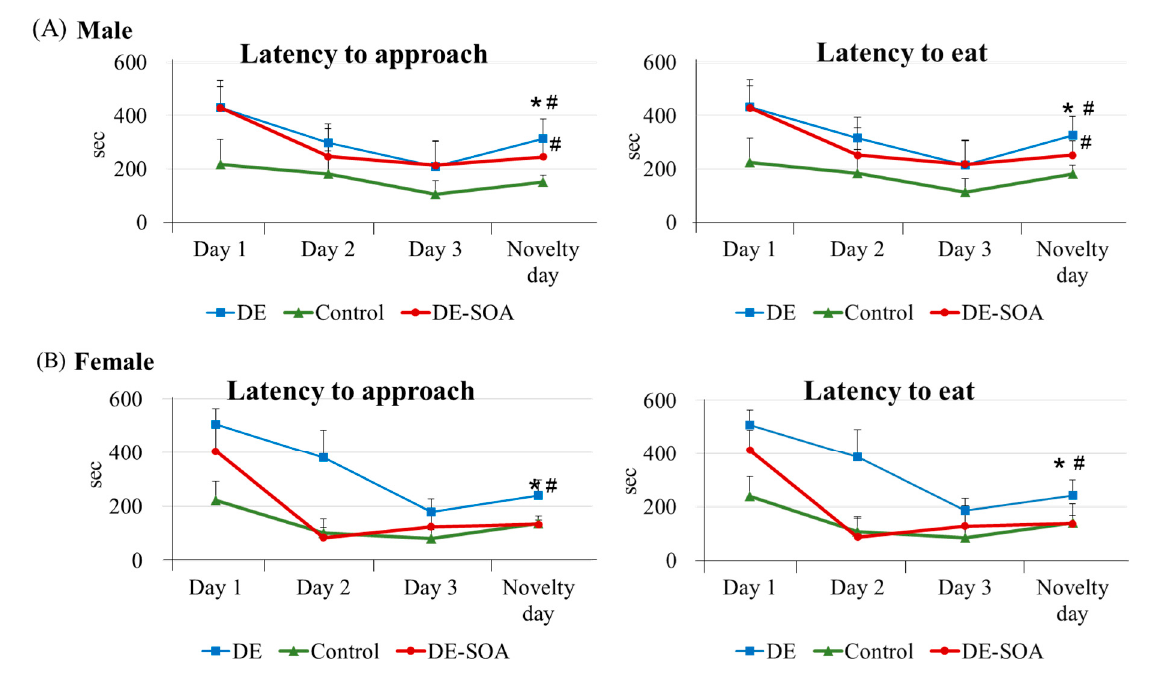
Figure 5. Novelty-induced hypophagia test. Latency to approach and latency to eat in 10-week-old ( A ) male and ( B ) female rats of the control and the DE- or DE-SOA-exposed groups ( n = 10, * p < 0.05 vs. corresponding Day 3 and # p < 0.05 vs. corresponding control group on novelty day).